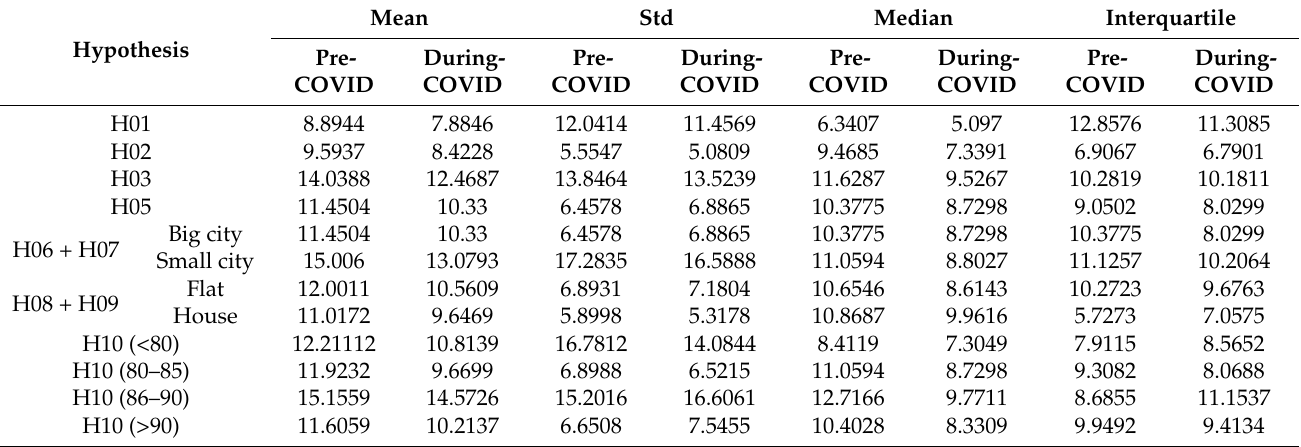
Table A3. Statistical values (mean, std, median and interquartile) for relevant hypothesis. The values in the table are percentages. A value of 100% activity corresponds to PA in every minute of the active part of the day (from 7 am to 10